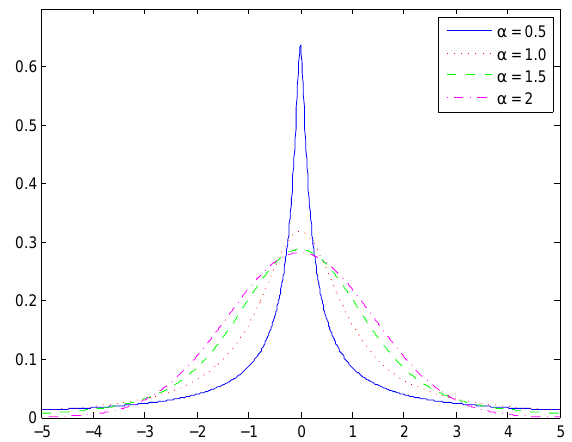
Figure 1. Probability density functions (PDFs) of alpha-stable distributions S ( α ,0,1,0 ) with different values of α